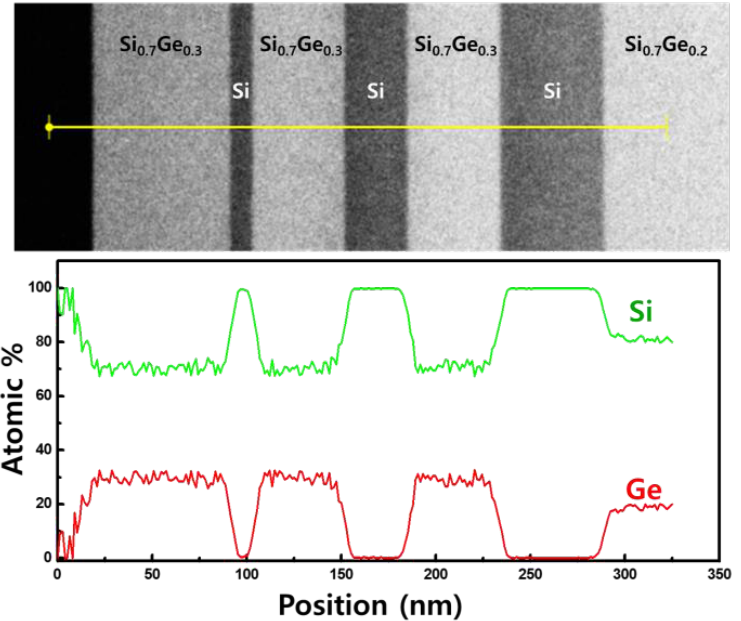
Figure 4. TEM cross-sectional images of Si/Si 0.7 Ge 0.3 multi-layer and profiles of Si and Ge with EDS line